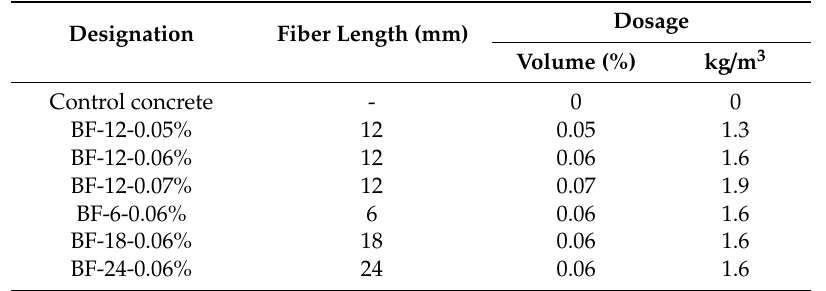
Table 2. Fiber length and dosages.